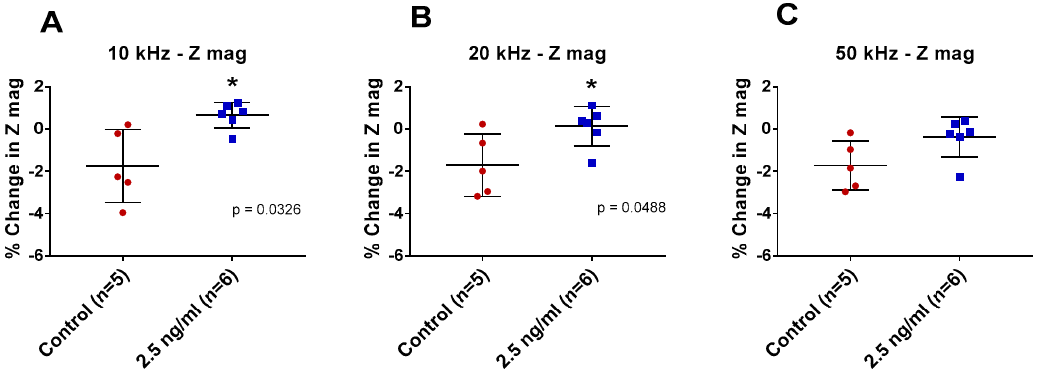
Figure 2. Percentage changes in impedance magnitude (Z mag) with pLDH. Functionalized interdigitated electrode (IDE) sensors were incubated with 2.5 ng/mL pLDH in phosphate-buffered saline (PBS) and non-spiked PBS at measurement frequencies ( A ) 10 kHz, ( B ) 20 kHz, and ( C ) 50 kHz. Error bars are standard deviation, * indicates p ≤ 0.05 (Welch’s t -tests).